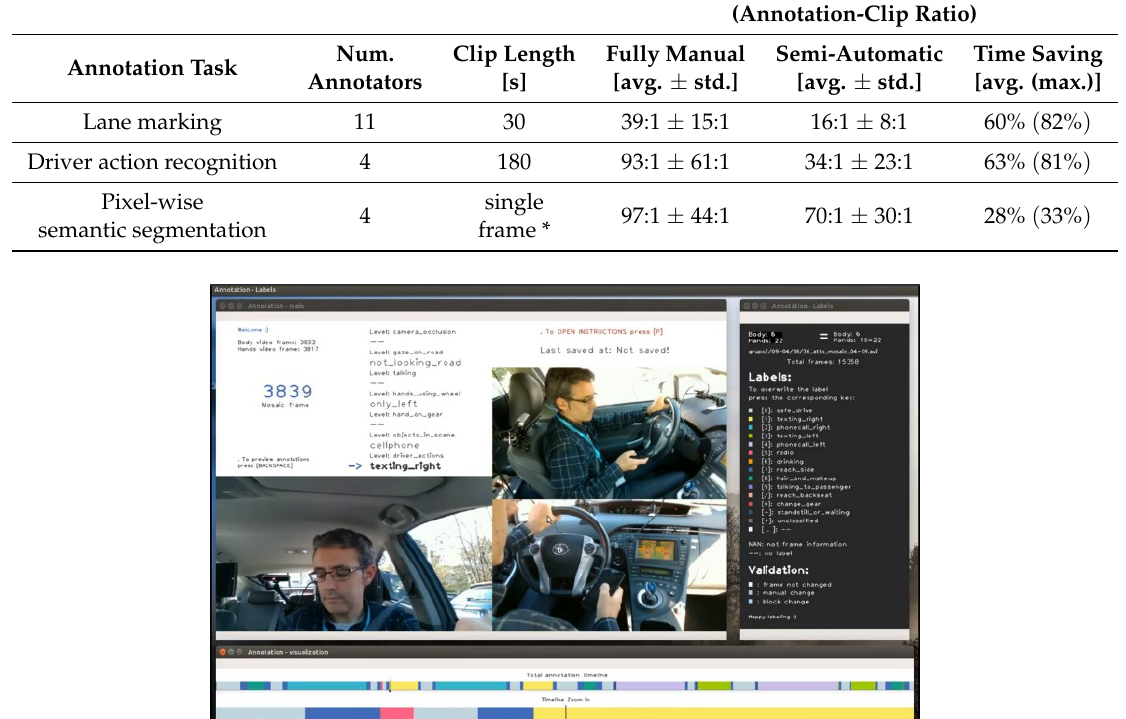
Table 3. Time spent by human operators to complete different annotation tasks versus sequence time. Specifically, it is the average time obtained from various human operators who performed the same annotation task, from scratch (fully manual) and from previous annotations (semi-automatic). The number of annotators per task, the length of the video, and the time savings due to the semi-automatic approach are also represented. * Note the pixel-wise annotation task was performed on a single image rather than a video.